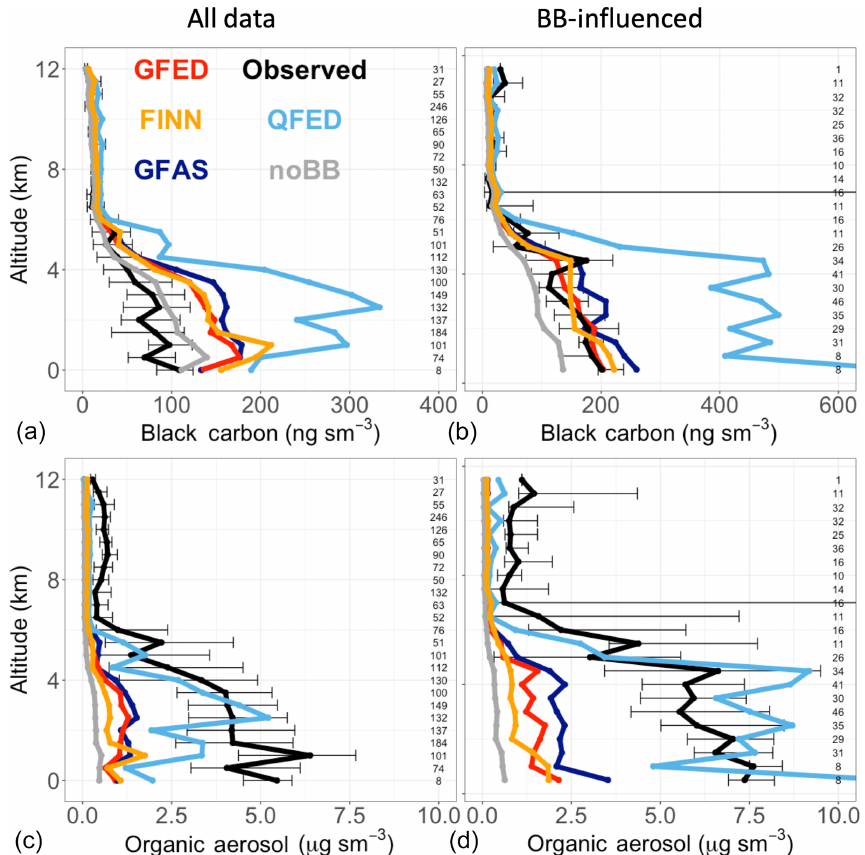
Figure 9. The median vertical profiles of BC and OA mass concentrations (shown in 0.5km bins) from the DC3 campaign. Observations (black) are compared with simulations using the four fire inventories – GFED4s (red), FINN1.5 (orange), QFED2.4 (light blue), and GFAS1.2 (dark blue) – and a simulation with no fire emissions (noBB) in gray. Error bars show the 25th–75th percentile range of measurements averaged in each vertical bin. The number of observations in each bin is given on the right side of each panel. Panels (a, c) show total results for the campaign. Panels (b, d) show results filtered for the top 25th percentile of observed acetonitrile. Note the different scale between BC